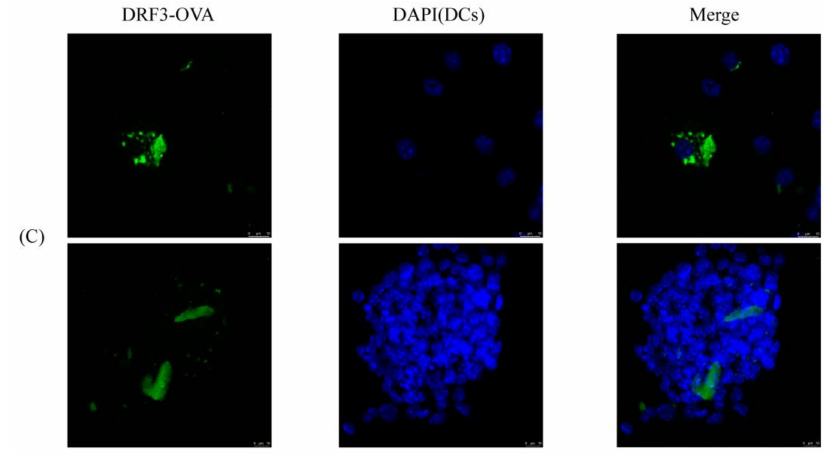
Figure 11. The effect on DCs recruitment. ( A ) DCs showed an aggregation growth state after OVA stimulation; ( B ) After stimulation with DRF3, DCs showed a state of largely aggregation growth, indicating that DRF3 can recruit DCs; ( C ) After being stimulated by DRF3-ova, DCs showed a large aggregation growth state, indicating that DRF3-ova can also recruit DCs, and the effect is better than DRF3 alone.